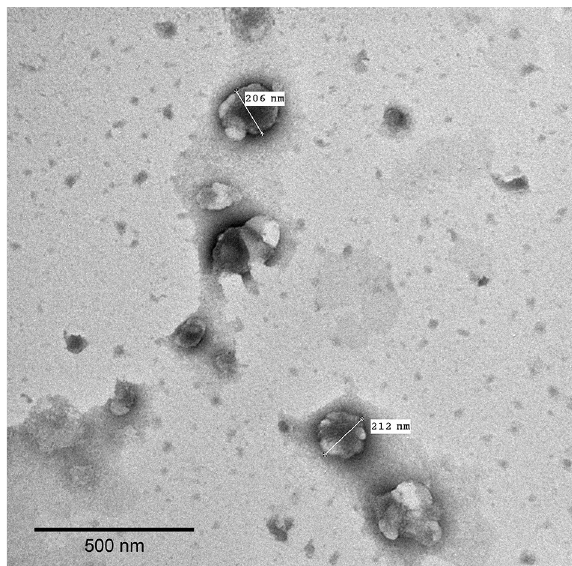
Figure 2. TEM image of F3.